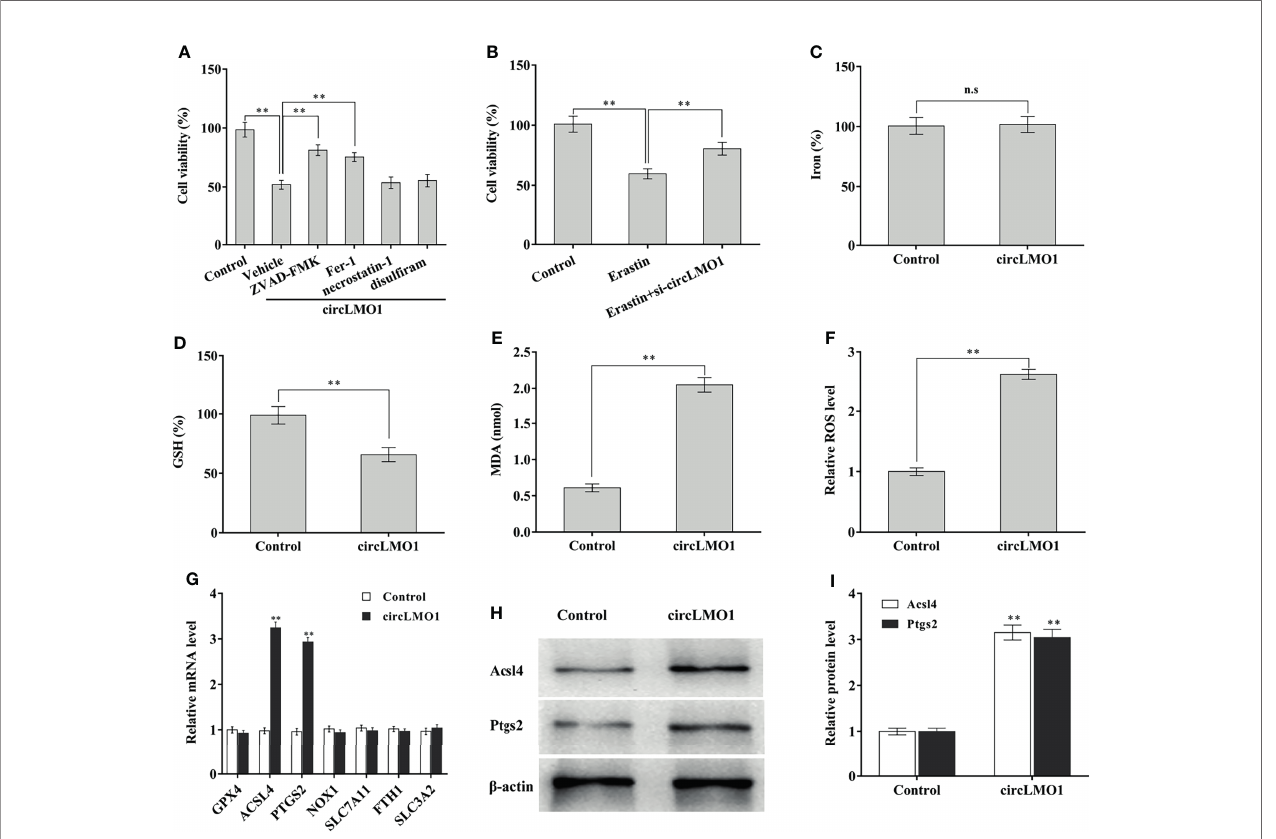
FIGURE 4 | CircLMO1 promotes cervical cancer cell ferroptosis. (A) CCK-8 assay was carried out to assess CaSki cell viability after circLMO1 overexpression in the presence or absence of ZVD-FEK, Fer-1, Necrostatin-1 and Disul fi ram. (B) CCK-8 assay was carried out to assess CaSki cell viability after Erastin treatment in the presence or absence of circLMO1 overexpression. Relative iron concentration (C) , GSH content (D) , MDA content (E) , and ROS level (F) was evaluated in CaSki cells after circLMO1 overexpression. (G) qPCR analysis was performed to assess the expression of ferroptosis-related genes in CaSki cells after circLMO1 overexpression. (H, I) Western blot and quantitative analysis of ACSL14 and PTGS2 protein levels in CaSki cells after circLMO1 overexpression. *p < 0.05, **p < 0.01, n.s, not signi fi